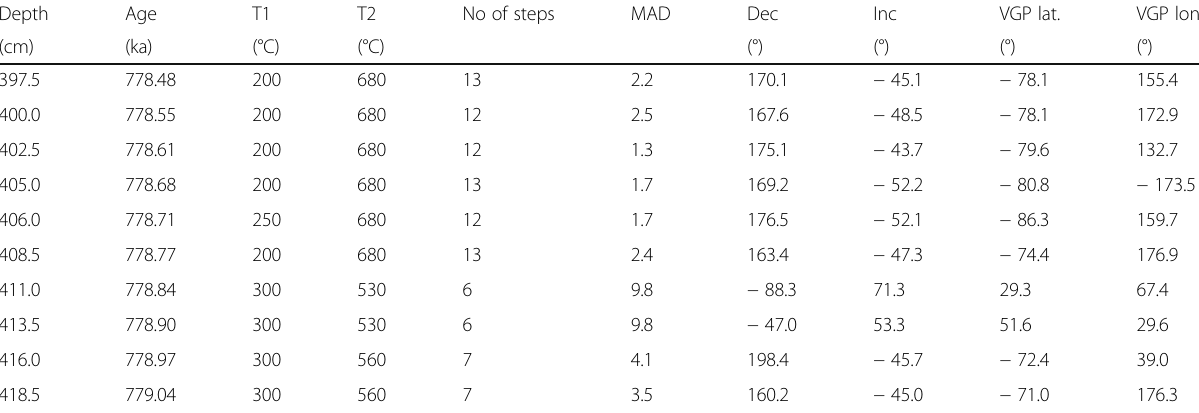
Table 1 Results of paleomagnetic analysis (Continued)